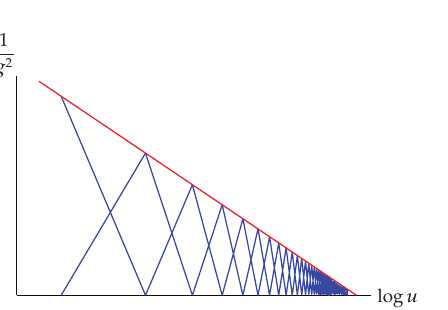
Figure 7: Qualitative plot of the running gauge couplings as functions of the logarithm of the energy scale in the cascading gauge theory. The blue lines are the inverse squared gauge couplings while the red line is their